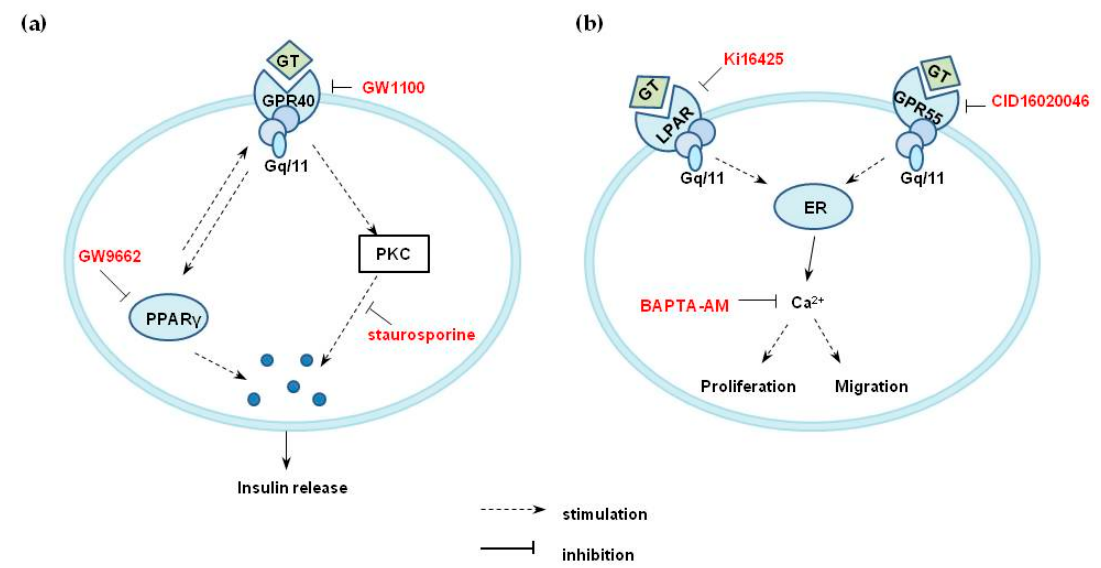
Figure 9. Proposed mechanisms for gintonin-induced insulin secretion in INS-1 cells ( a ), and gintonin-induced cell migration in PC-3 cells ( b ). ( a ) GPR40 activation by gintonin (GT) stimulated insulin secretion via PKC activation or other unknown signaling pathways in INS-1 cells. Neither PLC activation nor intracellular calcium mobilization was seen with the gintonin treatment of INS-1 cells. PPAR γ activation by gintonin might be partially responsible for gintonin-induced insulin secretion through indirect pathways. ( b ) GPR55 activation by gintonin (GT) might stimulate calcium release from the endoplasmic reticulum, elicit intracellular calcium mobilization, and induce cell migration in PC-3 cells. GT, gintonin; ER, endoplasmic